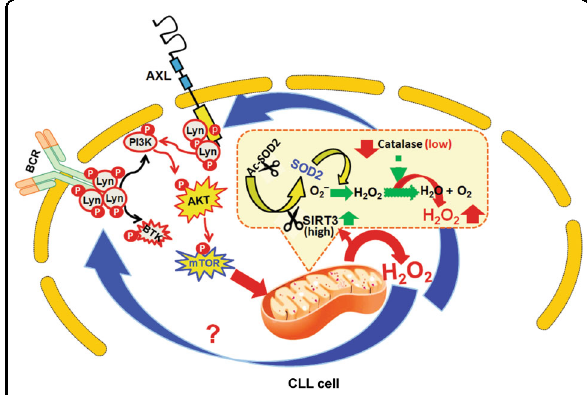
Fig. 6 Proposed model of ROS generation and regulation of survival signals in CLL cells. Data presented in this study demonstrate that CLL cells contain elevated levels of H 2 O 2 with signi fi cantly reduced O 2 − levels compared to normal B-cells. This is primarily due to the presence of highly active mitochondrial SOD2 enzyme in CLL cells converting O 2 − into H 2 O 2 more rapidly. Overexpression of SIRT3 in CLL cells deacetylates SOD2 and likely maintains its constitutive enzymatic activity. Moreover, we have also detected reduced expression of catalase in CLL cells causing H 2 O 2 - accumulation. Although we have identi fi ed two distinct CpG-Islands (I and II) for methylation in the human catalase promoter, our results suggest that it is the Island-I, which primarily regulates catalase levels in CLL cells. Indeed, we have detected variable degrees of methylation in CpG-Island-I of the catalase promoter only in CLL cells and not in normal B-cells and that, catalase expression is reduced in CLL cells both at mRNA and protein levels. While released from